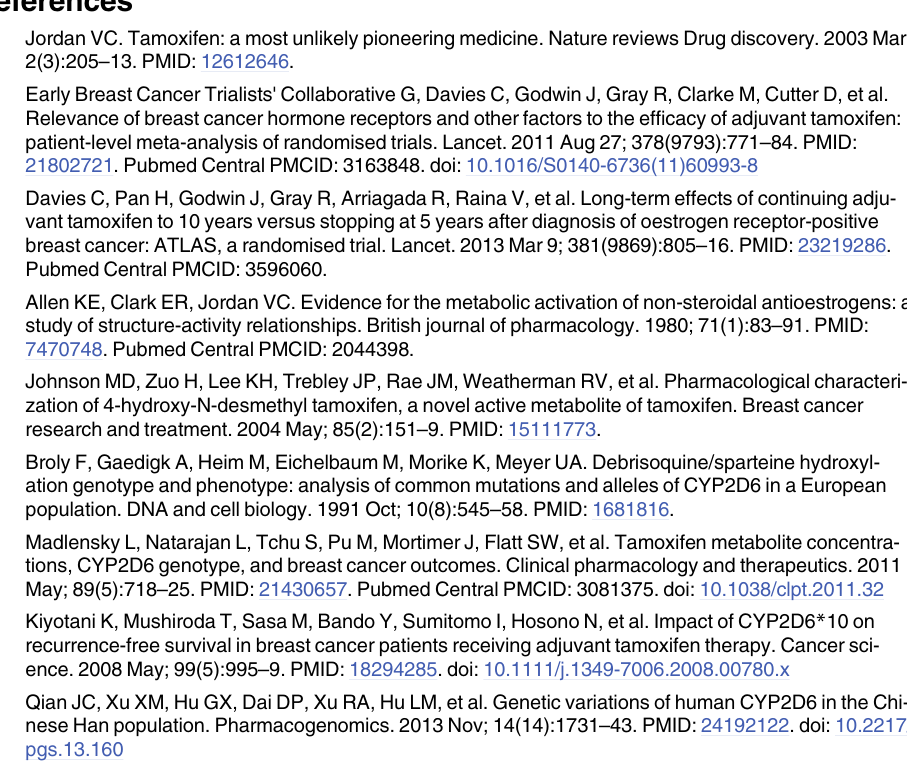
S1 Table. The names and locations of the 28 laboratories that participated in the CYP2D6 (cid:1) 10 PT